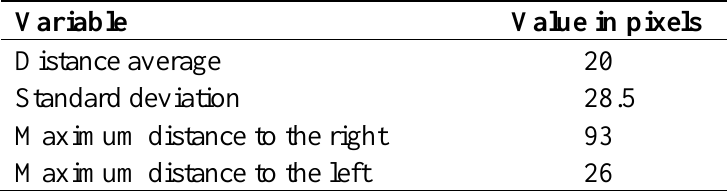
Table 1. Distances between the central crop row and the real center of the image on the horizontal axis for 306 frames.